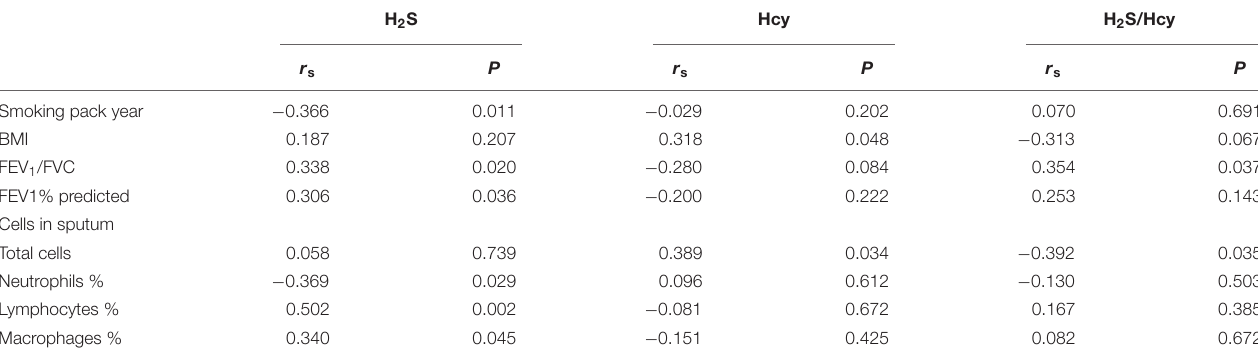
TABLE 6 | The correlations among H 2 S, Hcy, H 2 S/Hcy ratio and other variables. H 2 S Hcy H 2